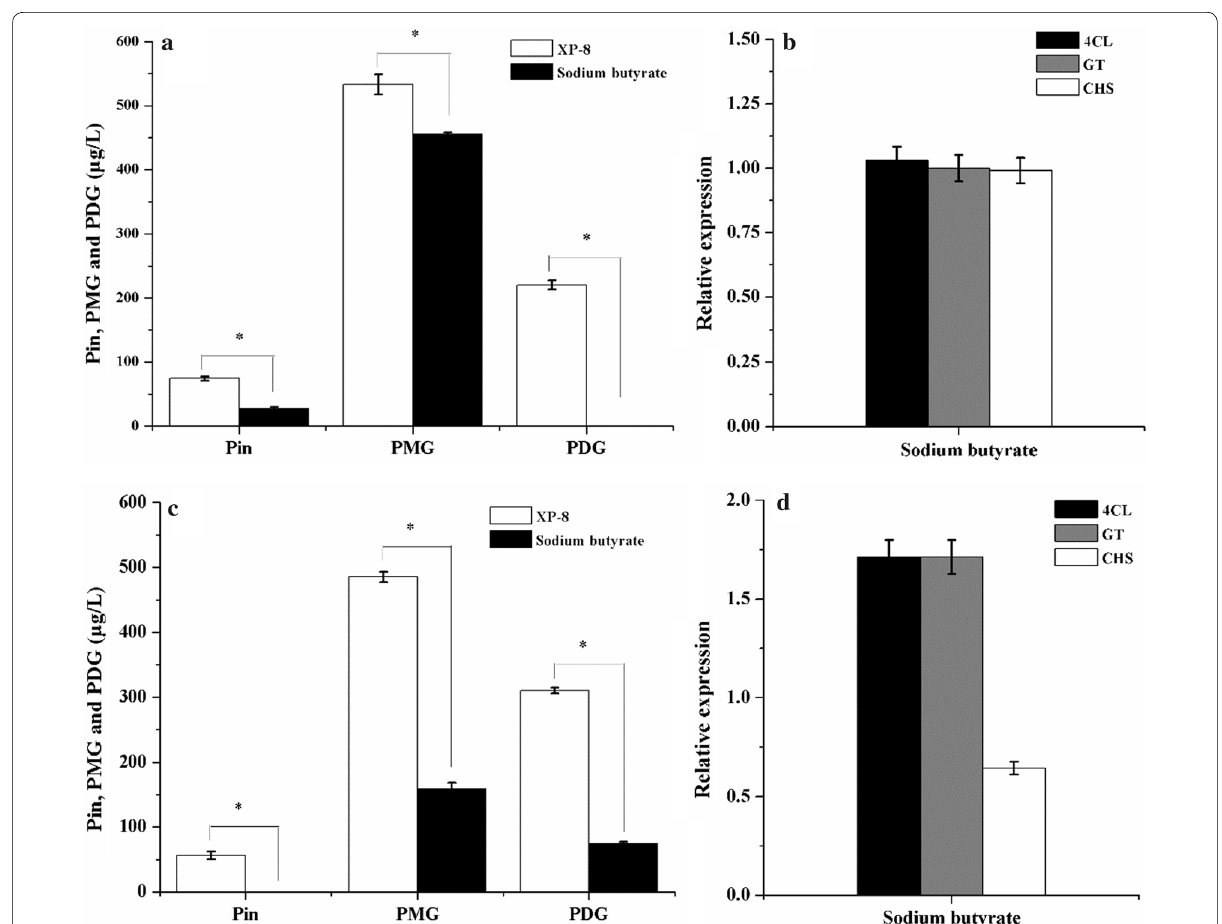
Fig. 7 Output levels of target products and expression levels of the genes obtained by sodium butyrate induction in the systems containing PDB ( a , b ) and resting cells ( c , d